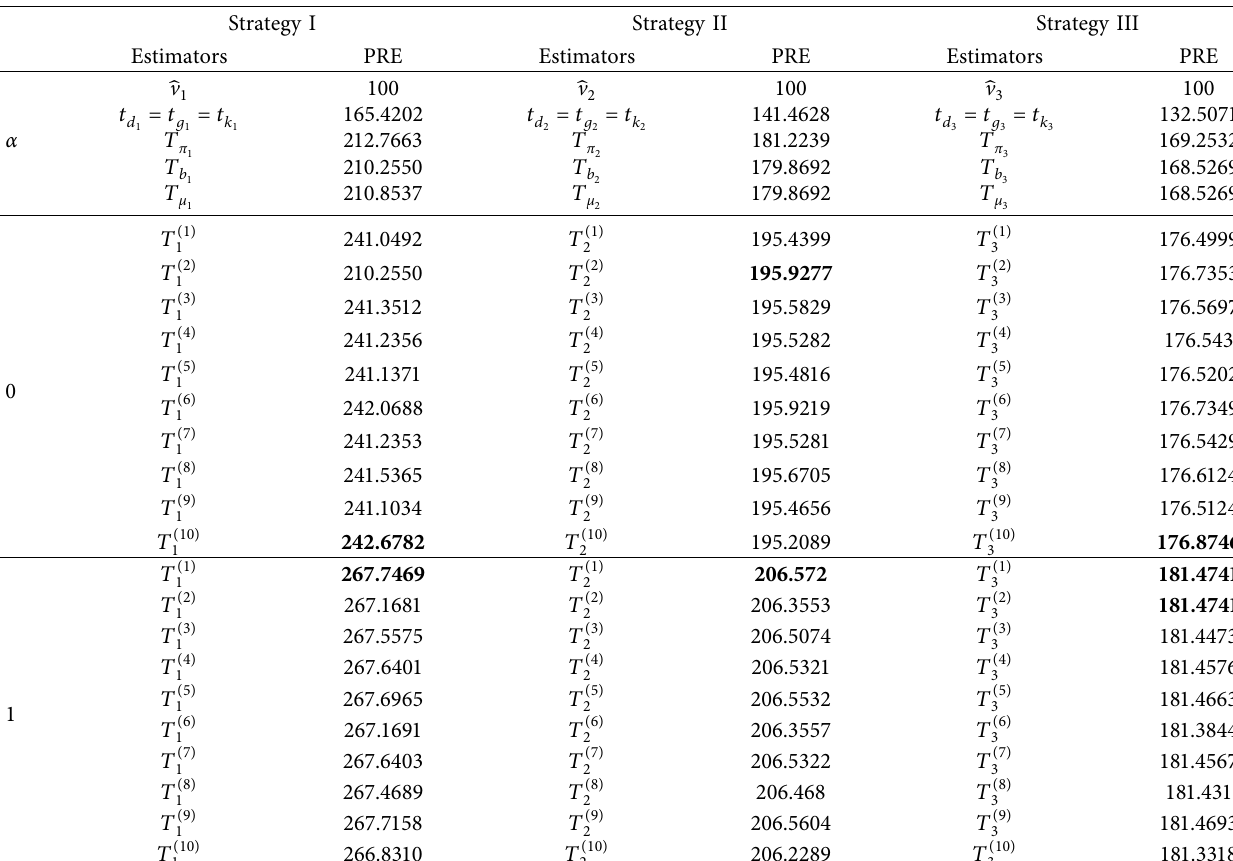
Table 3: PRE of the existing and proposed class of estimators for Population-I.